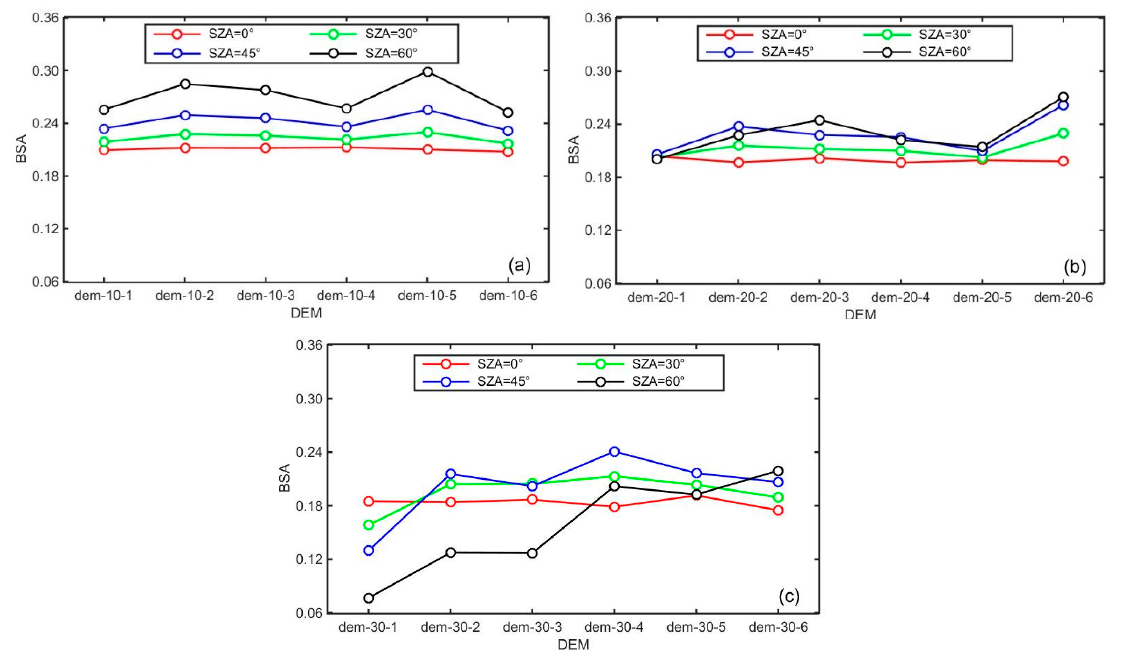
Figure 8. BSA variations with subpixel aspect distributions for terrains with different mean slopes: ( a ) 10°; ( b ) 20°; and ( c ) 30°. The SAA is 150°.